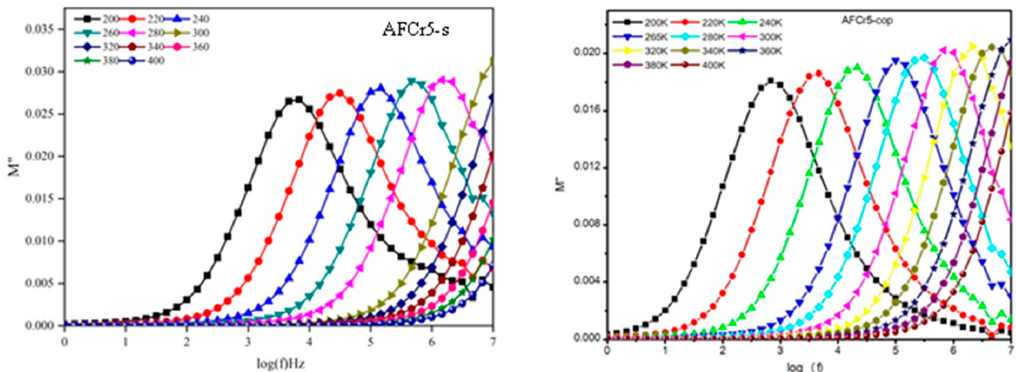
Figure 5. Frequency evolution of M” (imaginary part of electric modulus) at different temperatures for AFCr5-s and AFCr5-cop.